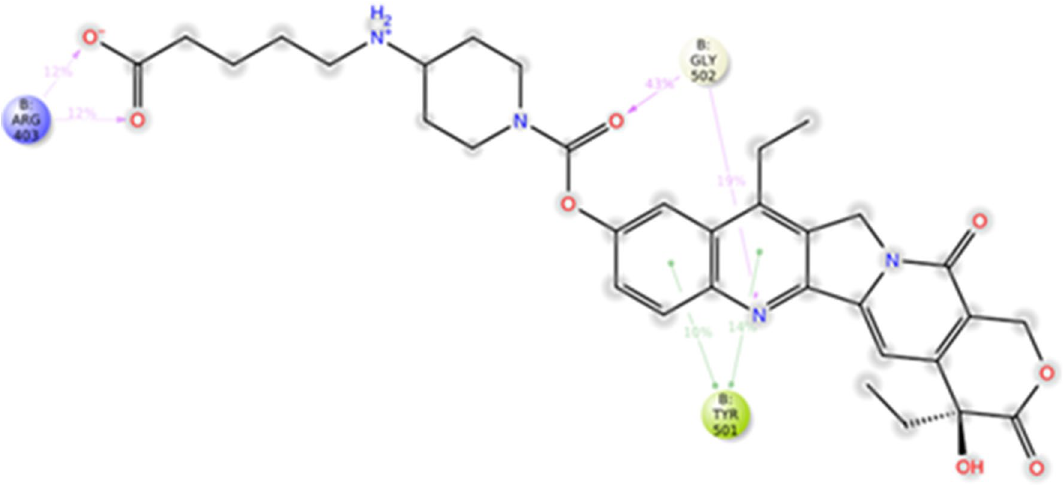
Figure 9. A schematic representation of the intermolecular interactions between #15 and Omicron Spike RBD.